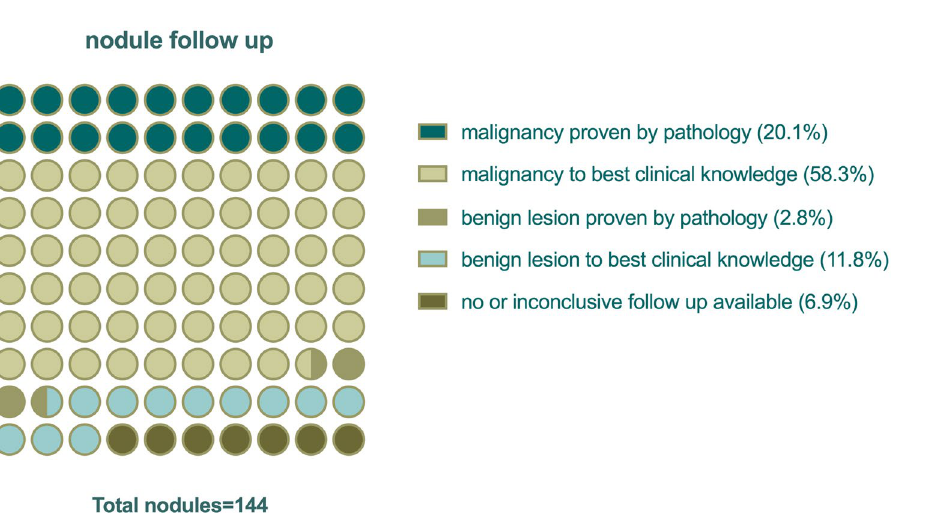
Figure 5. Analysis of nodule etiology during up to three years of follow-up is shown in a dot plot. The values of the parts per whole analysis are given in percent. All nodules ( n = 144) were